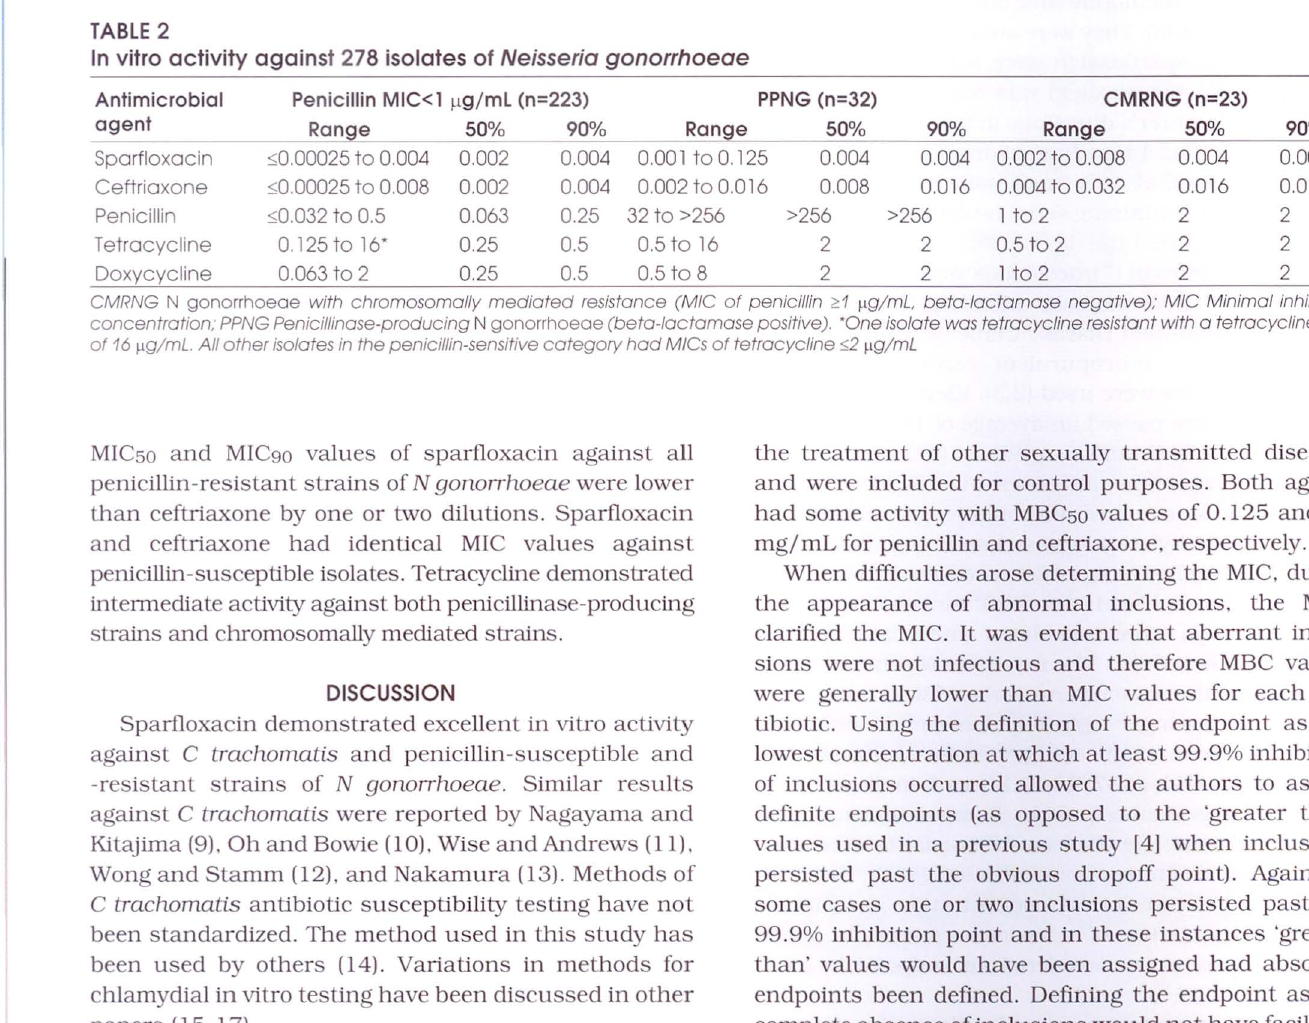
In vitro activity against 278 isolates of Neisseria gonorrhoeae